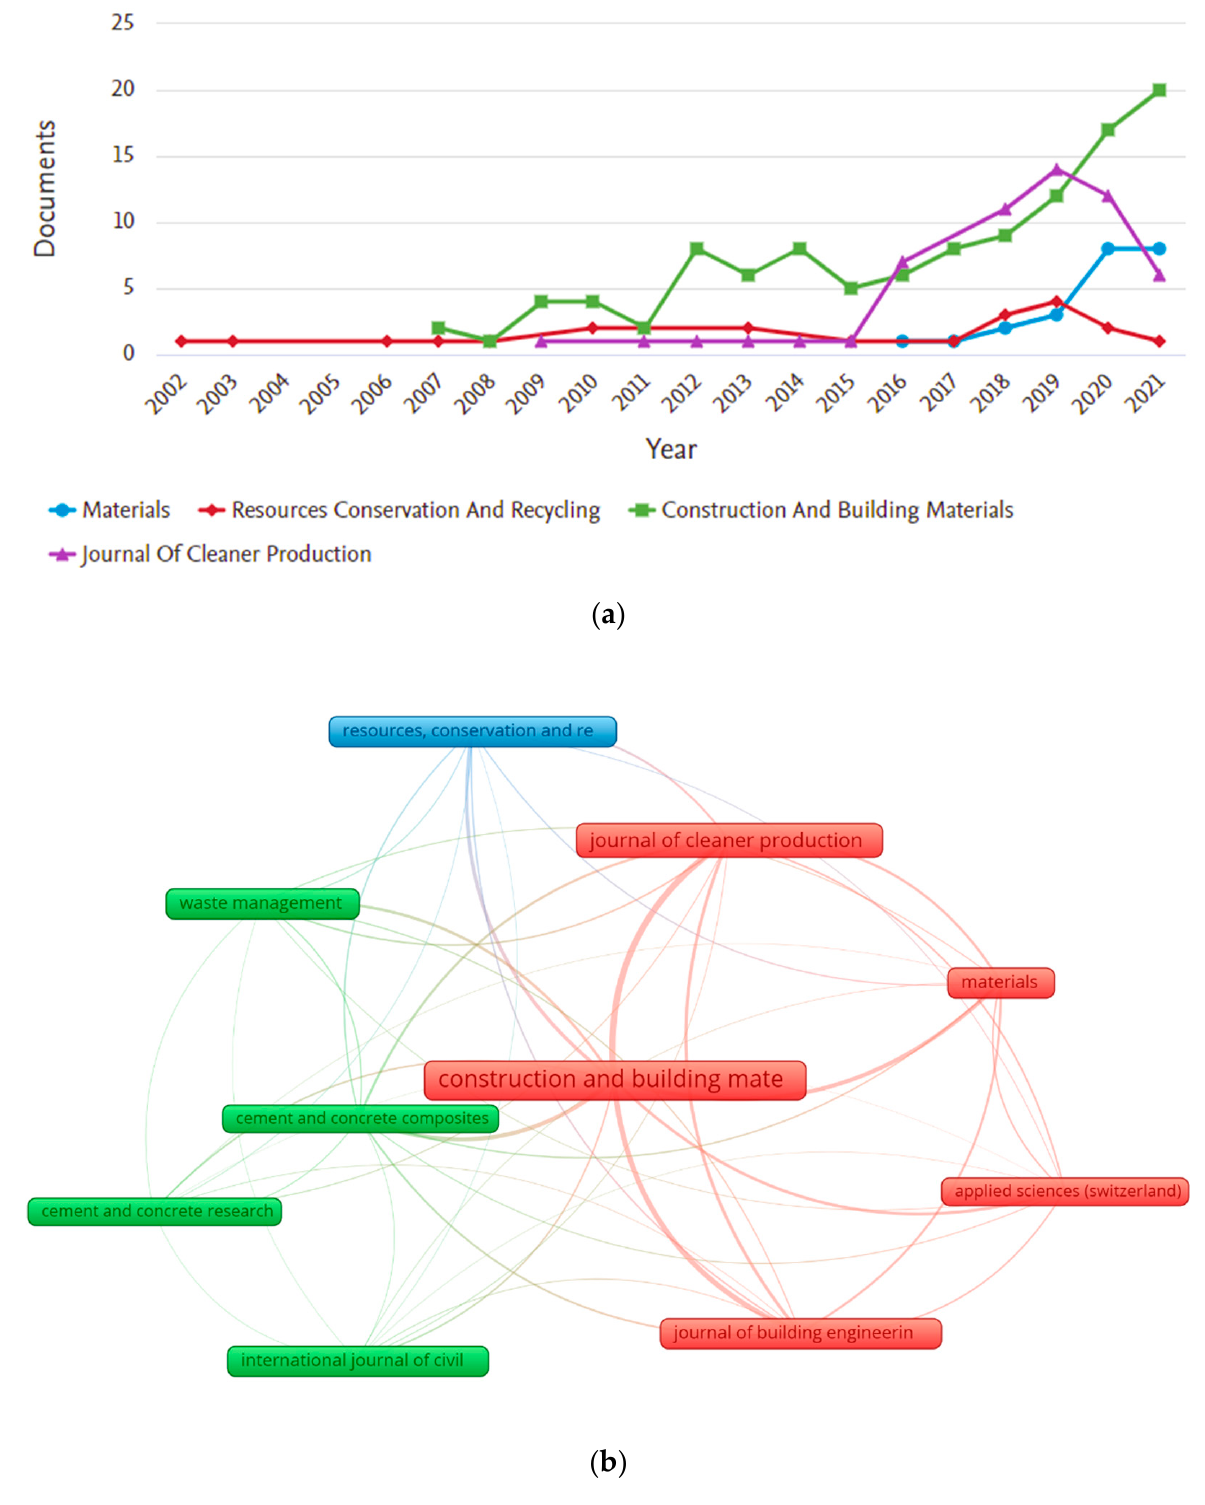
Figure 4. Sources of research articles: ( a ) yearly publication trend; ( b ) network visualization.